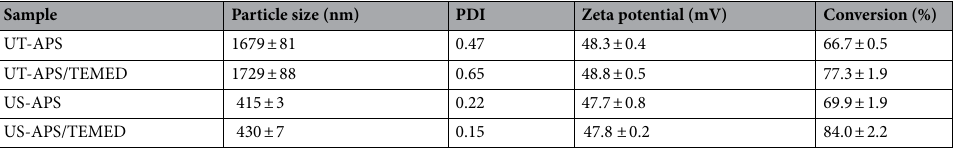
Table 1. Average particle size, polydispersity index (PDI), zeta potential, and the conversion percentage of NIPAM monomer during the preparation of PNIPAM@RS100 particles. Mean ± SD, n = 3, SD: standard